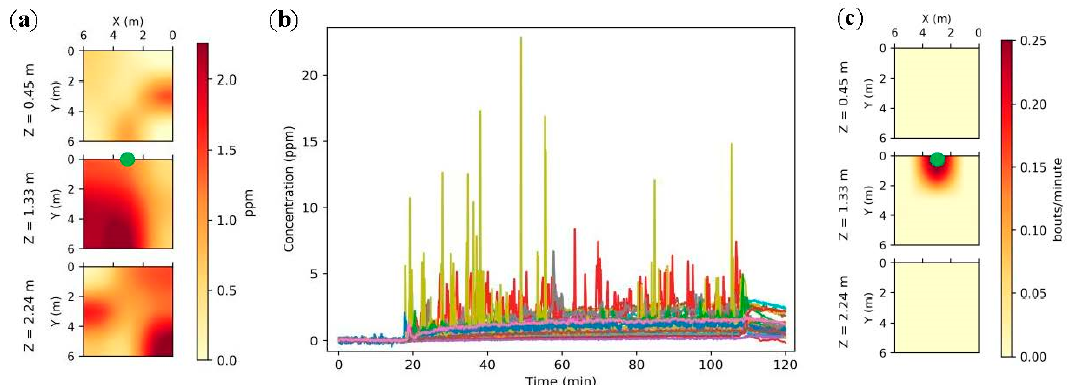
Figure 3. Gas dispersion without artificial airflow. ( a ) Mean gas distribution map at different heights, ( b ) Temporal evolution of the instantaneous concentration (all sensor signals are plotted); ( c ) Average bout frequency map (bout amplitude threshold is 5